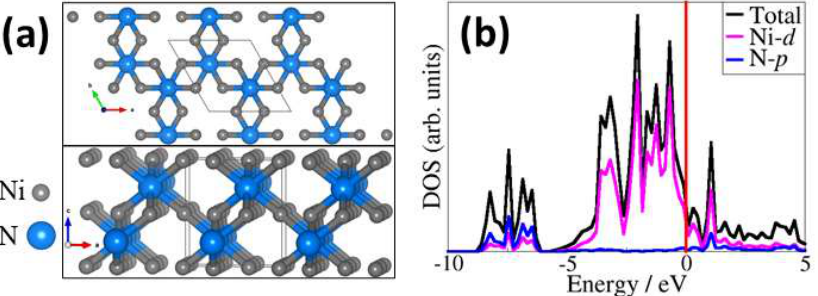
Figure 1. ( a ) Top and side views of the bulk Ni 3 N crystal structure. ( b ) PDOS of bulk Ni 3 N, showing metallic character through fermi level occupation at 0 eV.